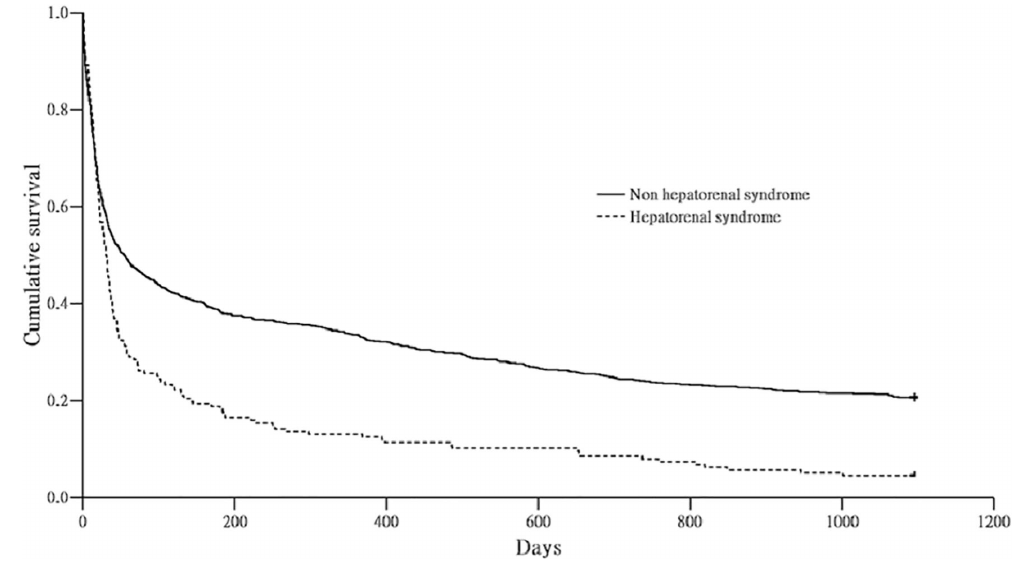
Fig 2. Cumulativesurvivalplotfor ARF cirrhotic patientswithand withouthepatorenal syndrome.